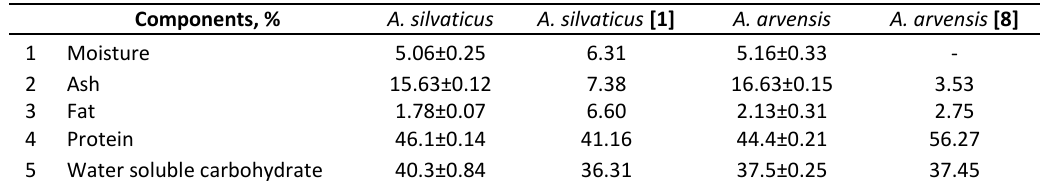
Table 1. The chemical composition of Agaricus